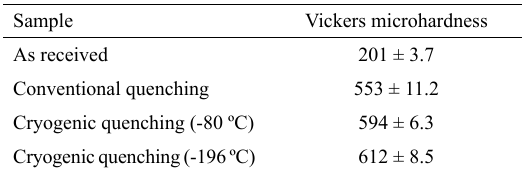
Table 5. Vickers microhardness values for each kind of sample (1 kgf for 15